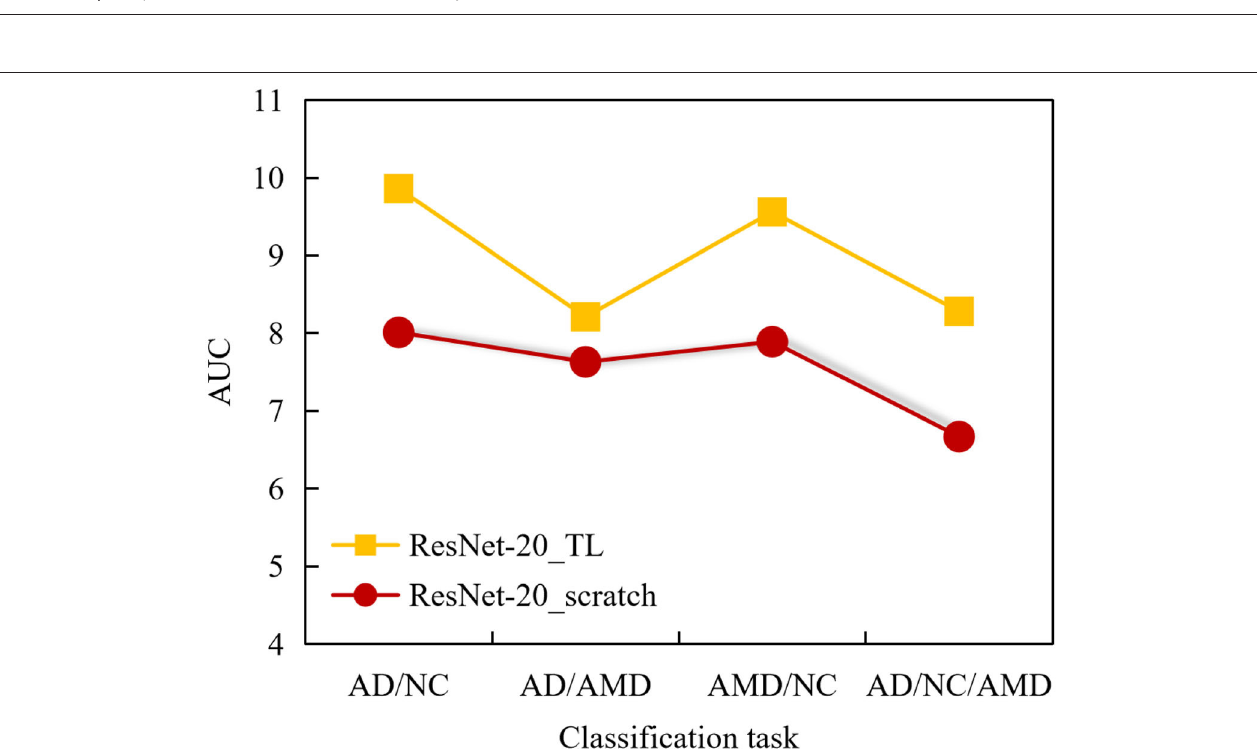
FIGURE 9 | AUC comparison curves of 2 ANN models in classification tasks AMD/NC, AD/NC, AMD/AD, and AD/AMD/NC.